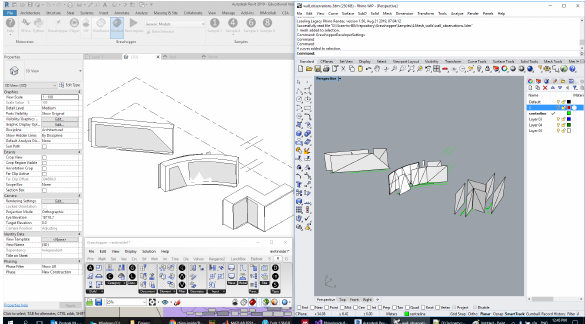
Figure 5: Overview of the three wall cases. The interface of Revit and Rhino showcase the observed and reconstructed wall geome- try which are linked through the Rhino.Inside